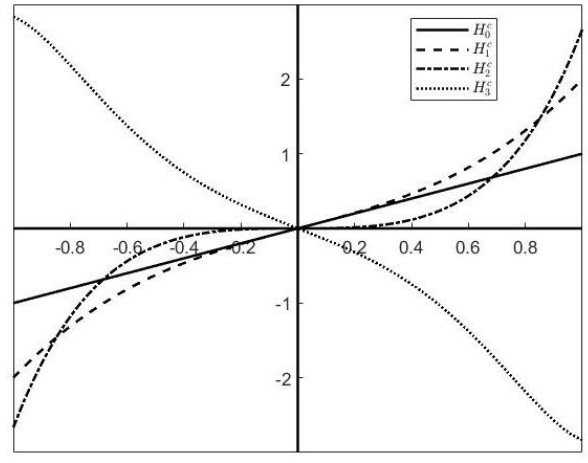
Figure 3. Odd Hermite-central factorial